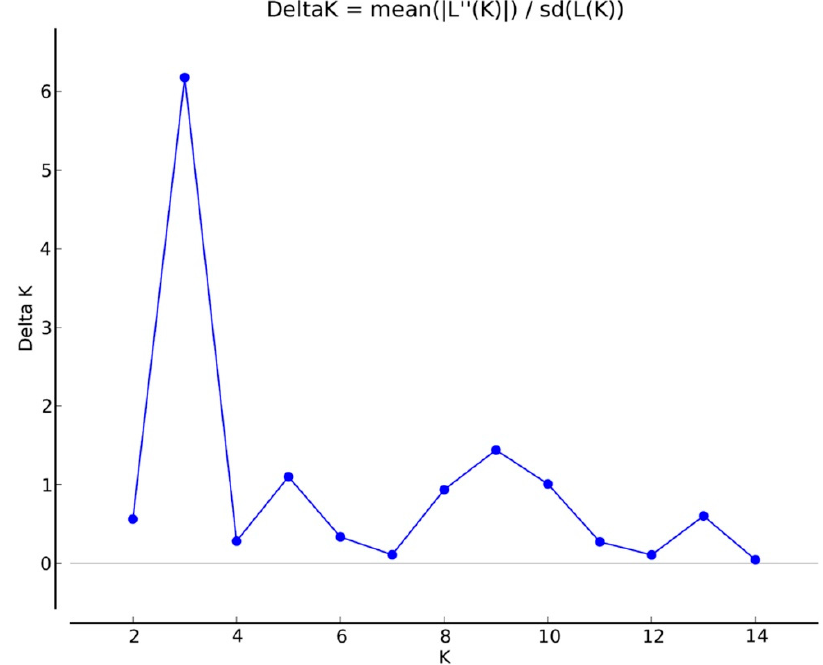
Figure 5. Plot of delta K values from the structure analyses of 68 Rhizoctonia isolates.